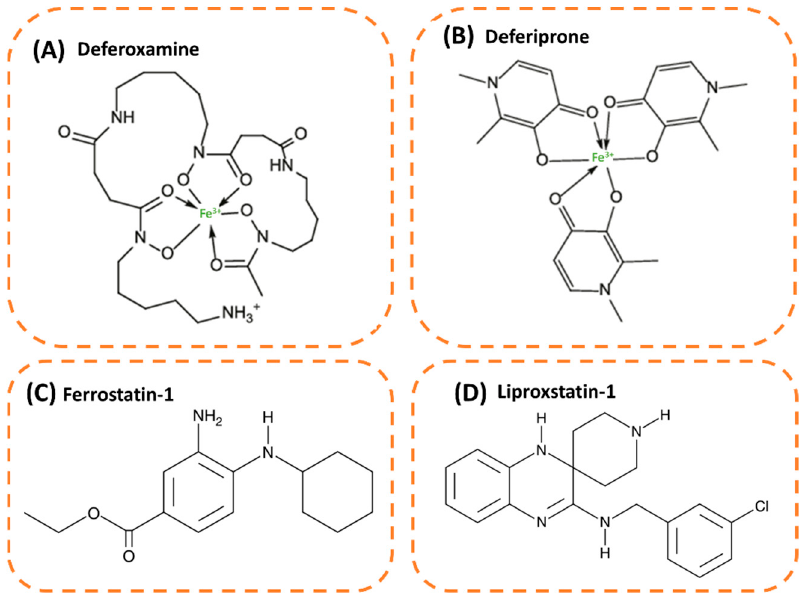
Figure 6. Chemical structures of iron chelators: ( A ) Deferoxamine chelating iron and ( B ) 3 Deferiprone chelating iron, and lipophilic antioxidants: ( C ) Ferrostatin-1 and ( D ) Lipoxstatin-1 .